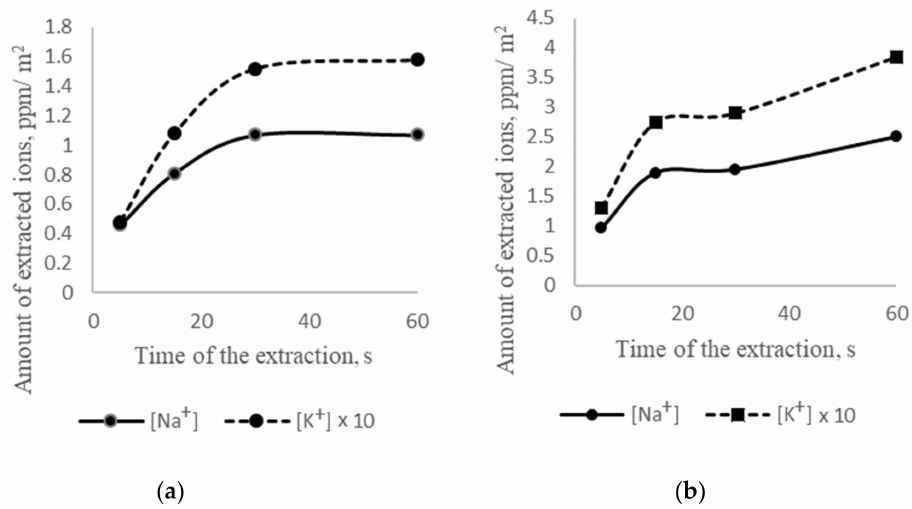
Figure 2. The amount of extracted Na + and K + vs. temperature and time of the extraction process from the mortar’s surface layers: ( a ) 295 K and ( b ) 368 K.